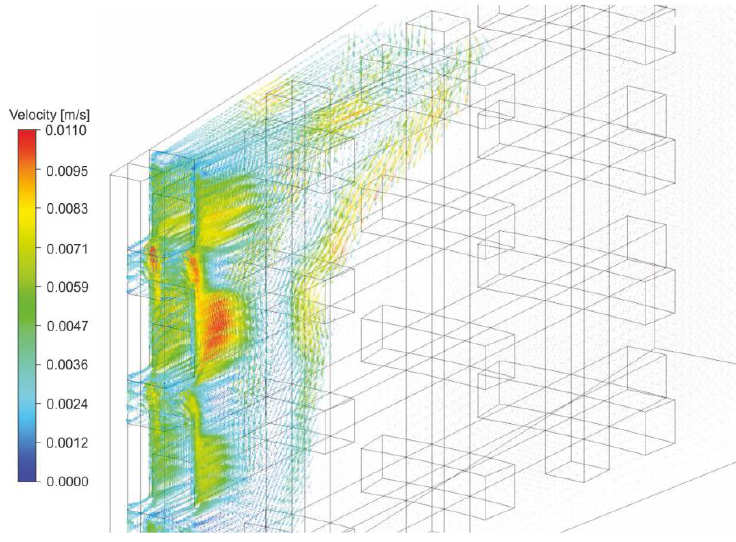
Figure 7. Vector plot of the liquid velocity of the PCM 225 s after simulation start.